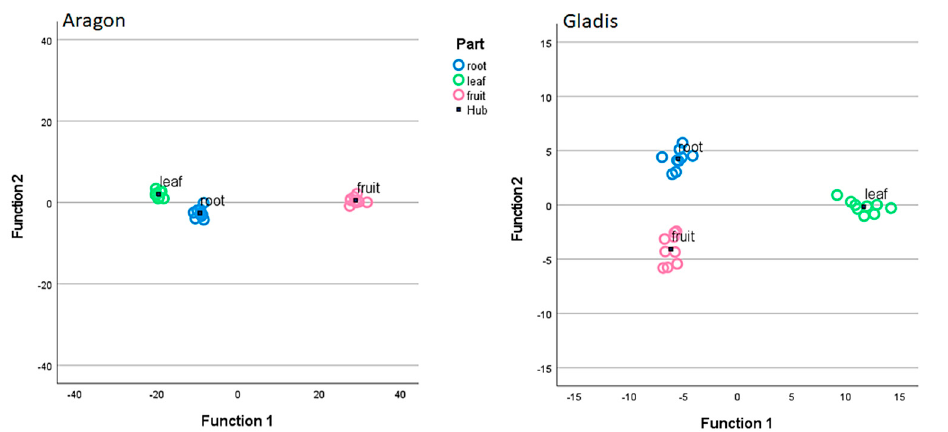
Figure 2. Discriminant canonical functions analysis for the chemical analyses according to treatments (Control, Si Low, Si High) and grouped by parts of the plant: blue = leaf, green = root, pink = fruit. Blue square = hub of the group. Left side Aragon, right side Gladis.